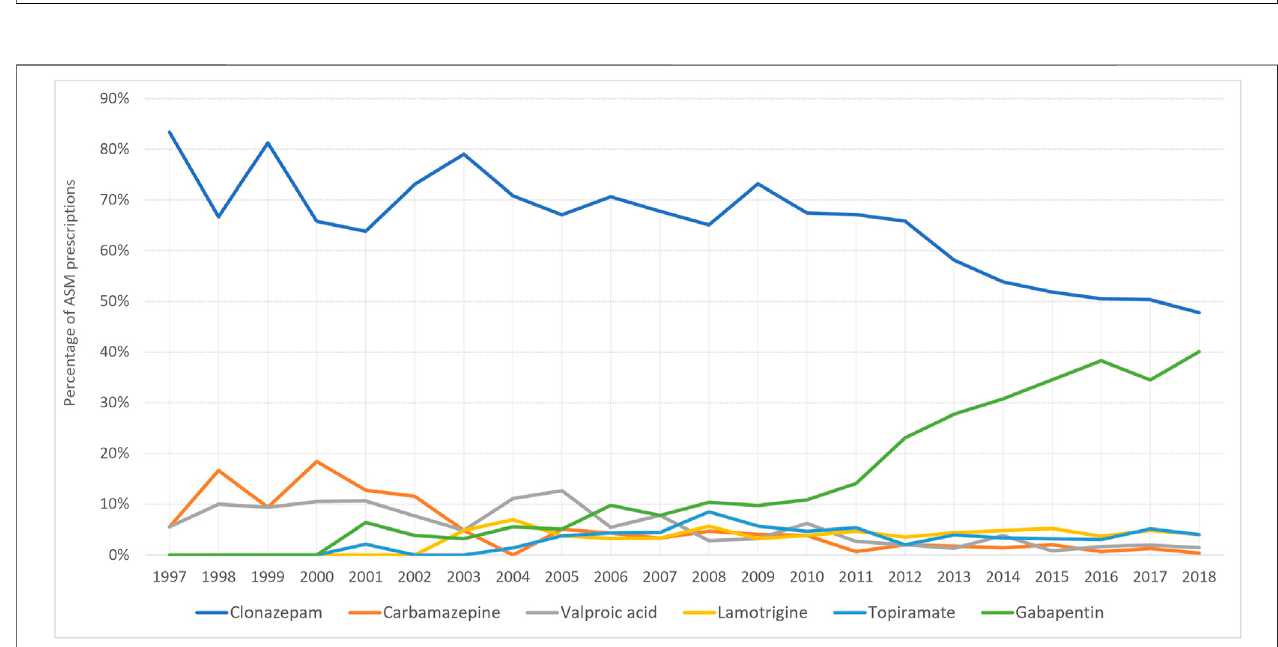
FIGURE 4 | Trends of top ASM prescriptions among pregnant women with epilepsy.